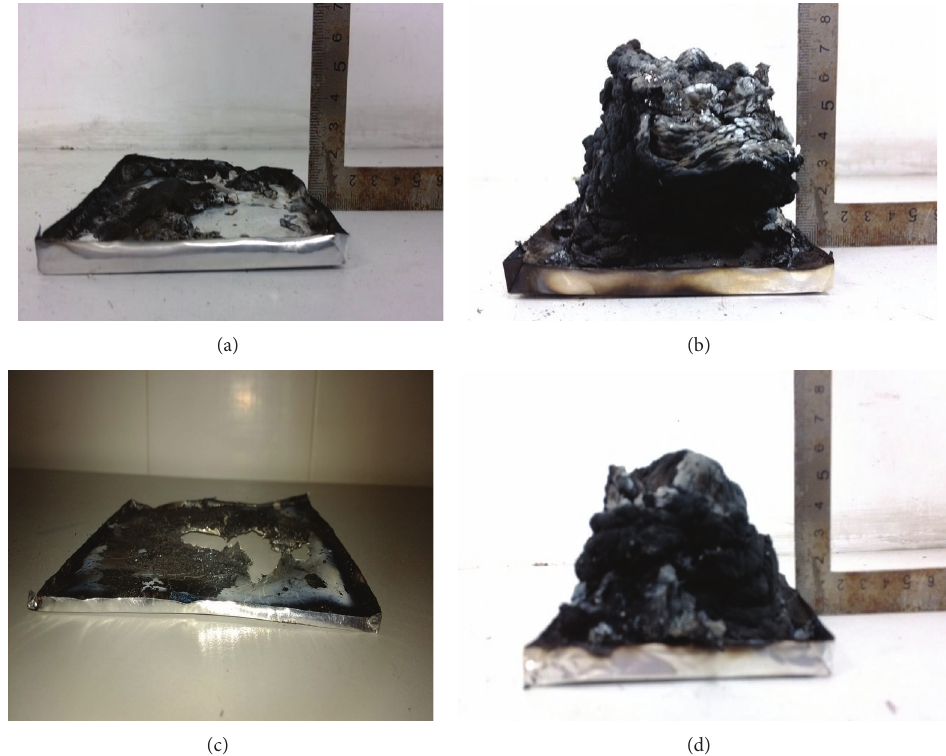
Figure 8: Photos of the residue obtained in the cone calorimeter test: (a) PA6; (b) flame-retarded PA6 with ADPP; (c) flame-retarded PA6 with ME; (d) flame-retarded PA6 with ADPP/ME.